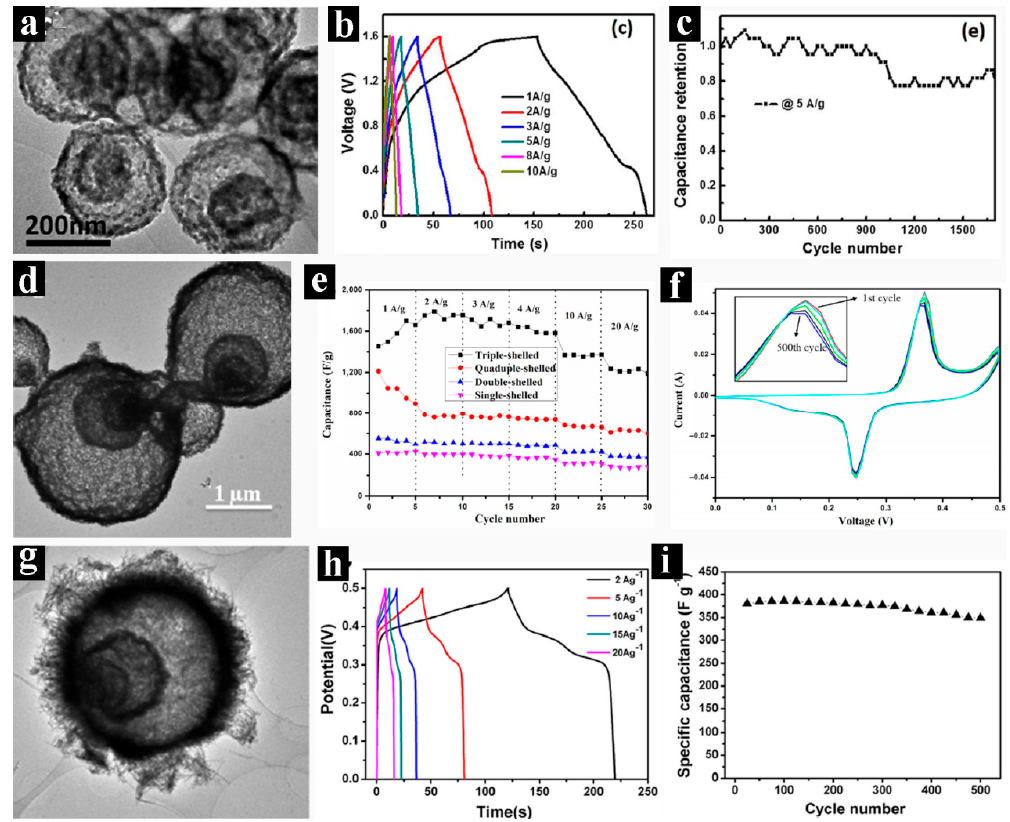
Figure 15. Transmission electron microscopy (TEM) images of triple-shell and multi-shell spheres and their supercapacitors (SCs) performance: ( a ) TEM image of the NiCo 2 O 4 triple-shelled hollow spheres (TSHSs), ( b ) galvanostatic charge and discharge (GCD) curves and ( c ) cycling performance of the NiCo 2 O 4 // RGO@Fe 3 O 4 ACSs. ( d ) TEM image, ( e ) rate-capability test at various current densities (1–20 A g − 1 ), and ( f ) cycling performance at a sweep rate of 50 mV s − 1 of the CoFe 2 O 4 triple-shelled hollow spheres (TSHSs). ( g ) TEM image, ( h ) GCD curves at di ff erent discharge currents, and ( i ) cycling performance at 2 A g − 1 of the Co 3 O 4 multiple-shelled hollow spheres (MSHSs). Pictures ( a ), ( b ), and ( c ) were reprinted with permission from Reference [130]. Pictures ( d ), ( e ), and ( f ) were reprinted with permission from Reference [139]. Copyright Springer, 2016. Pictures ( g ), ( h ), and ( i ) were reprinted with permission from Reference [66]. Copyright Elsevier,